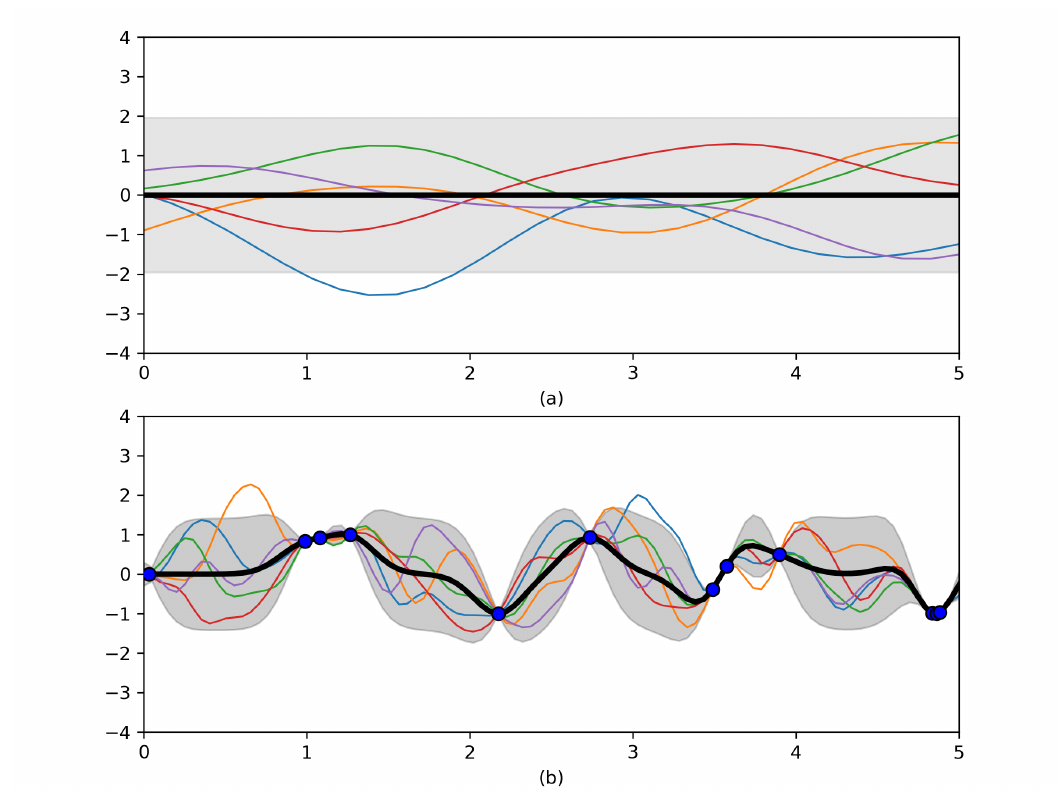
Figure 3. ( a ) Five samples from a radial basis function (RBF) kernel prior. ( b ) Five samples from the posterior after conditioning on twelve noise-free datapoints obtained from f ( x ) = sin ( x 2 )